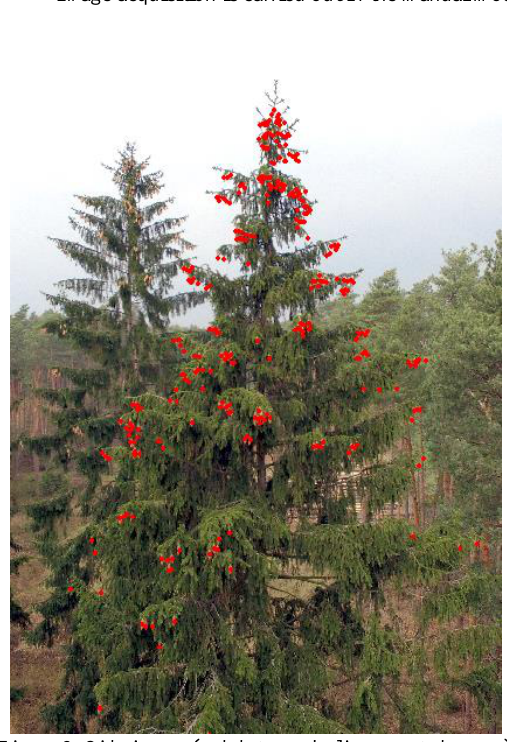
Figure 3. Side image (red dots symbolize counted